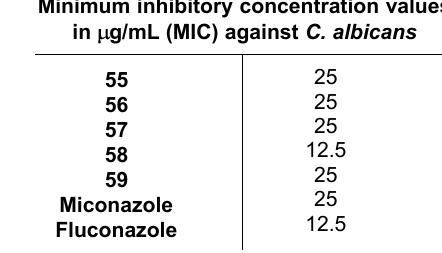
Figure 22. Antifungal coumarins.